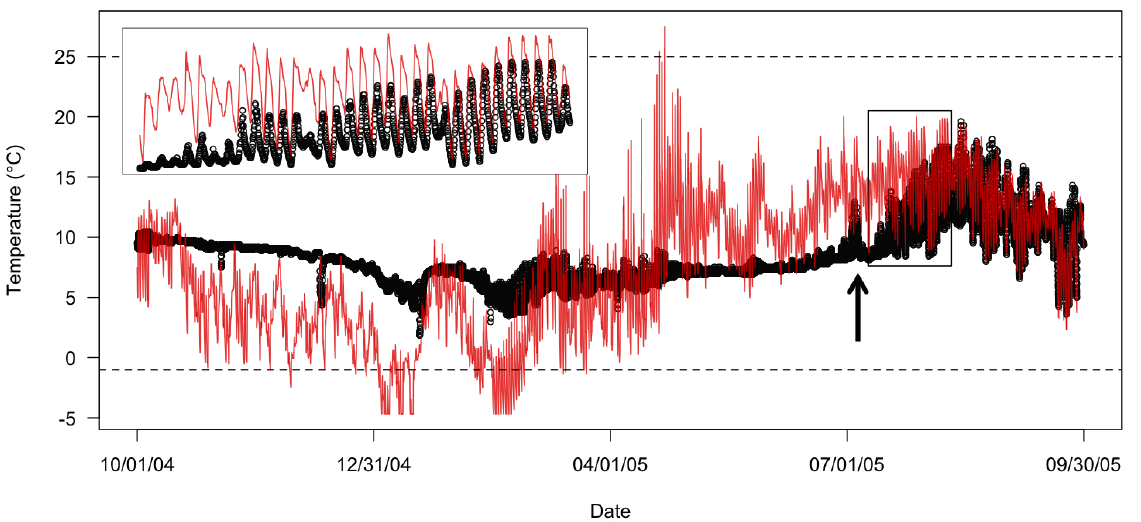
Figure 1. Identifying a dewatering event by comparing water temperature data to reference air temperature